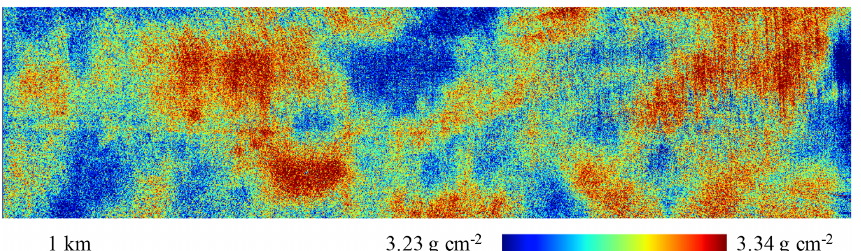
Figure 8. H 2 O vapor maps. In flight lines A and B, dark blue areas are masked to avoid clouds. A white arrow in flight line B indicates an artifact that occurs where the solar phase angle is zero. A white box in flight line C indicates the area shown by Fig.